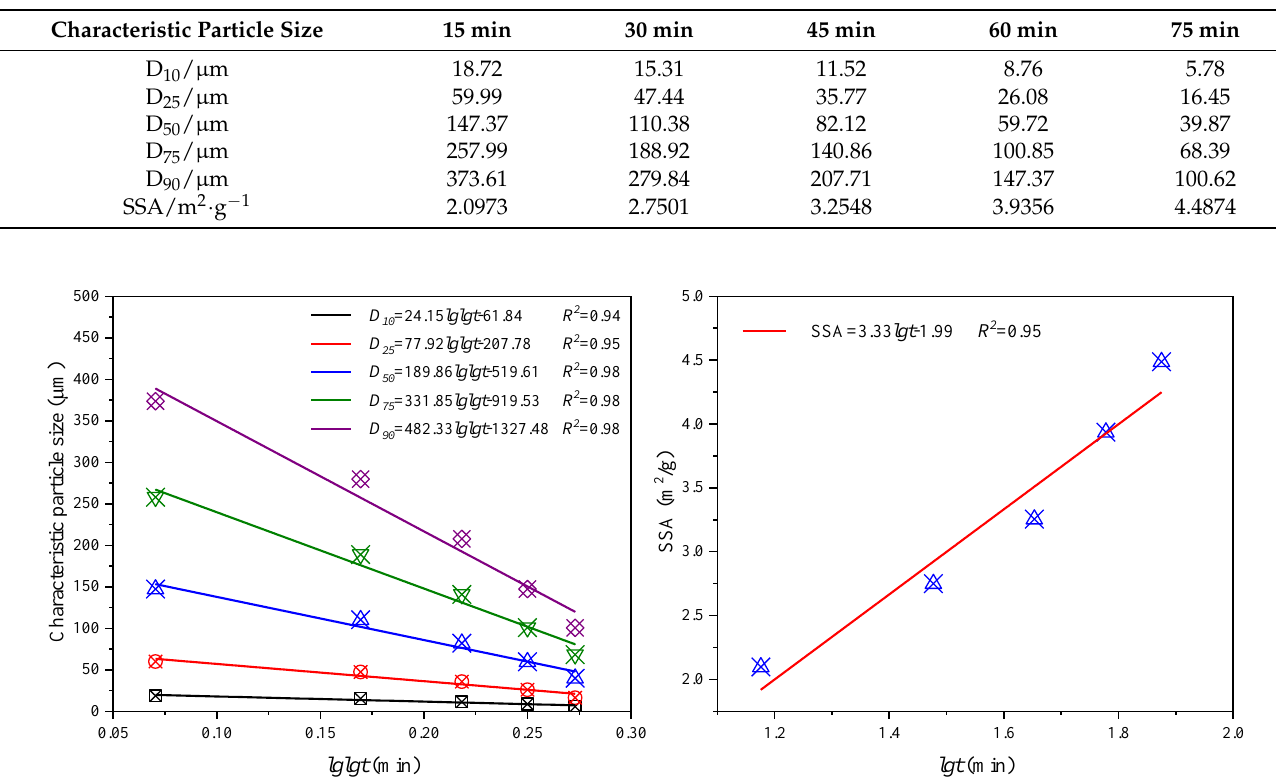
Figure 7. Relationship between characteristic particle size, SSA and grinding time of CGS.